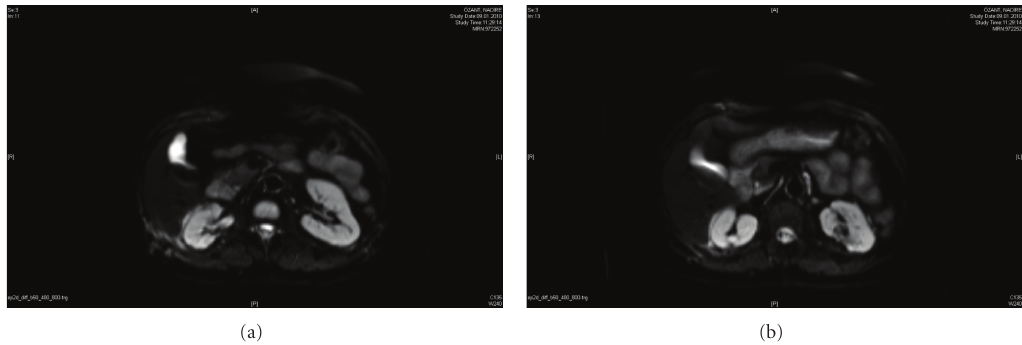
Figure 6: MRI scans performed 2 years after surgery, documenting no tumoral